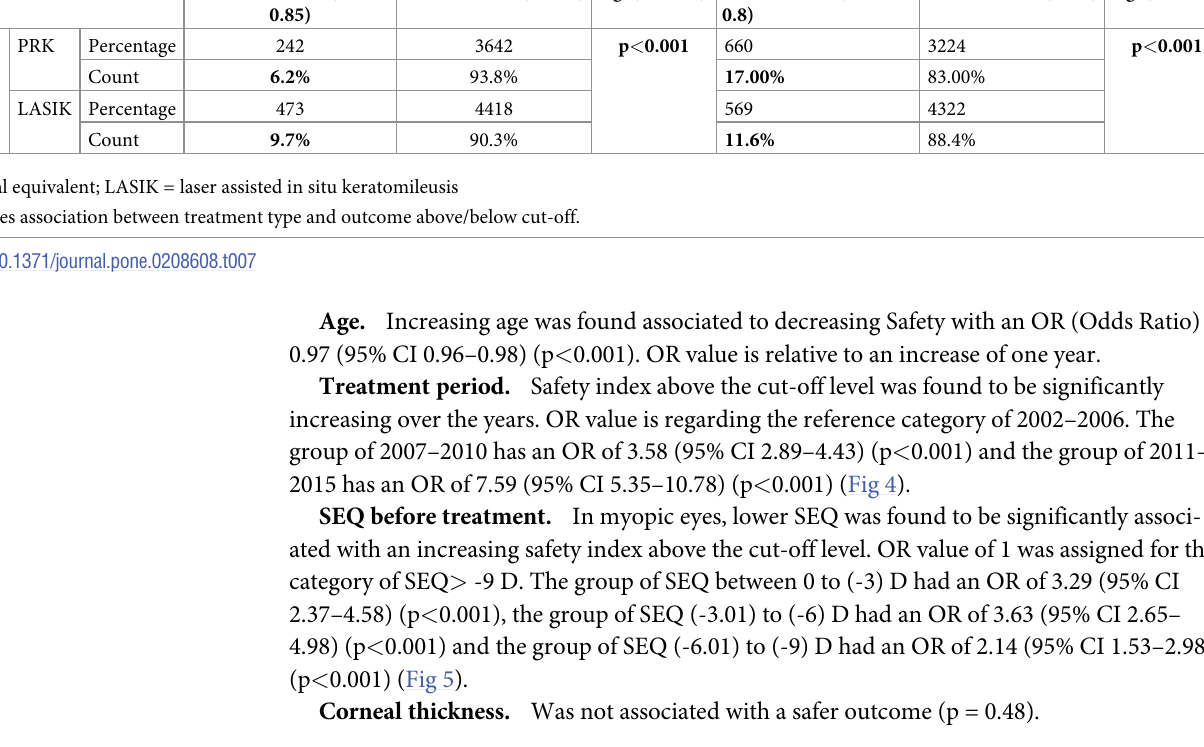
Table 7. Correlation between treatment type and safety and efficacy (Pearson Chi-Square).